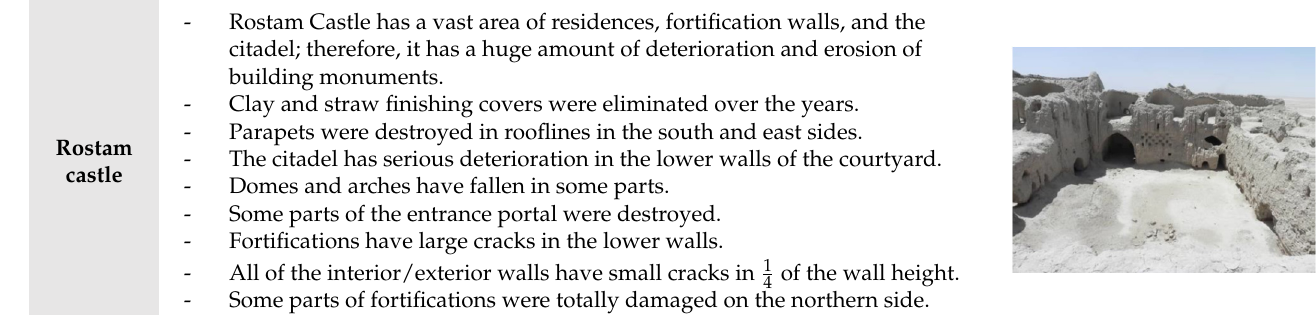
Table 3. Investigation of general damages in case studies.